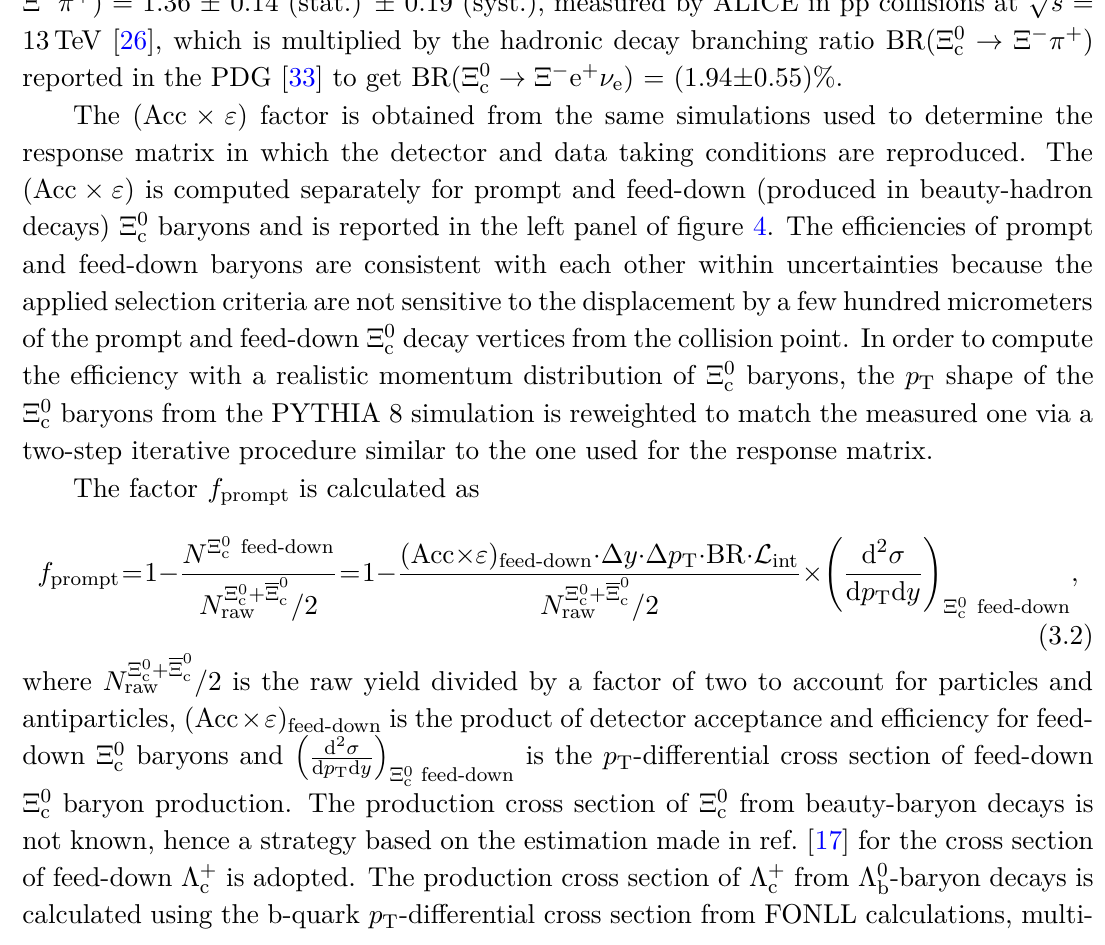
Figure 4 . Left panel: product of acceptance and efficiency for prompt and feed-down Ξ 0 √ pp collisions at s = 5.02 TeV as a function of p T . Right panel: fraction of prompt Ξ 0 raw yield ( f prompt ) as a function of p T . The systematic uncertainties of f prompt are shown as boxes.